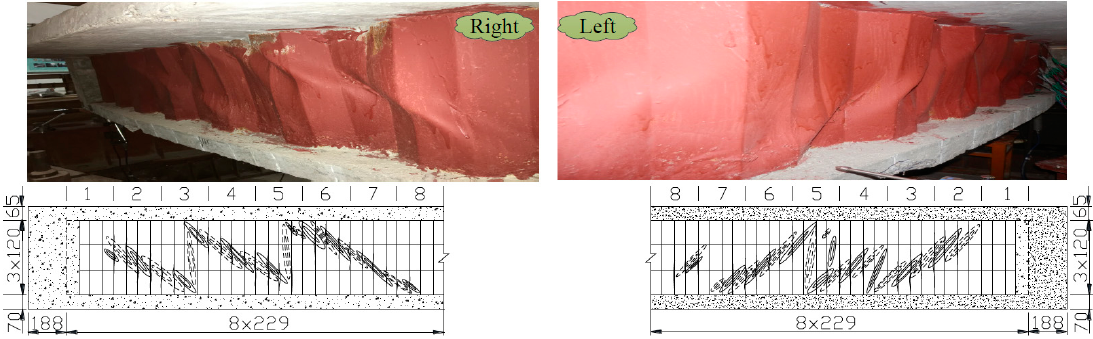
Figure 15. The final buckling shapes of outer CSW for specimen S2-t2d2. Right: the right-hand side of test girders. Left: the left-hand side of test girders.